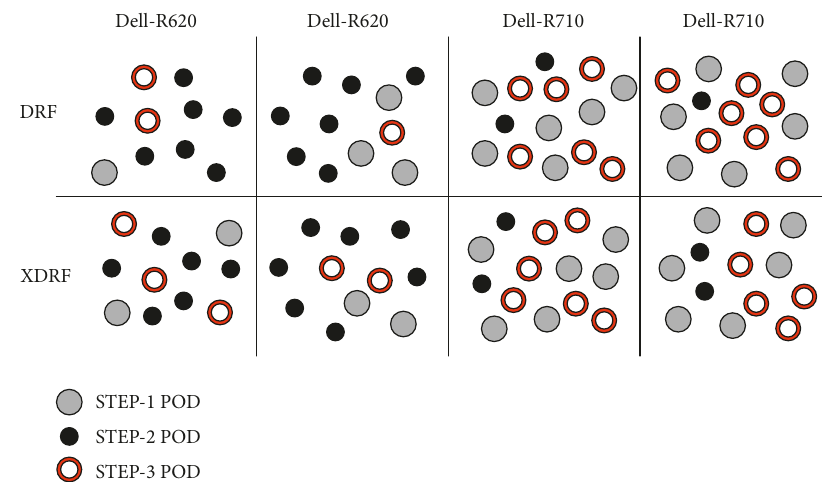
Figure 5: Resource allocation results of different resource allocation algorithms under the same load.